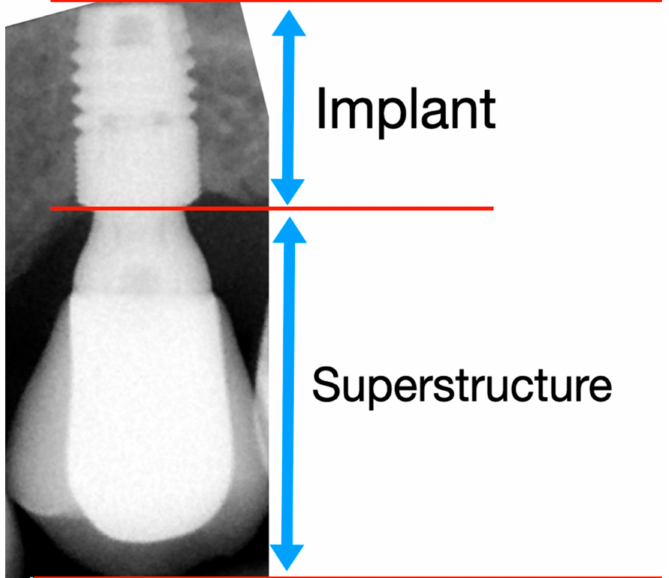
Figure 5. Crown-to-implant ratio was determined by dividing the length of the superstructure (crown and the abutment) by the length of the